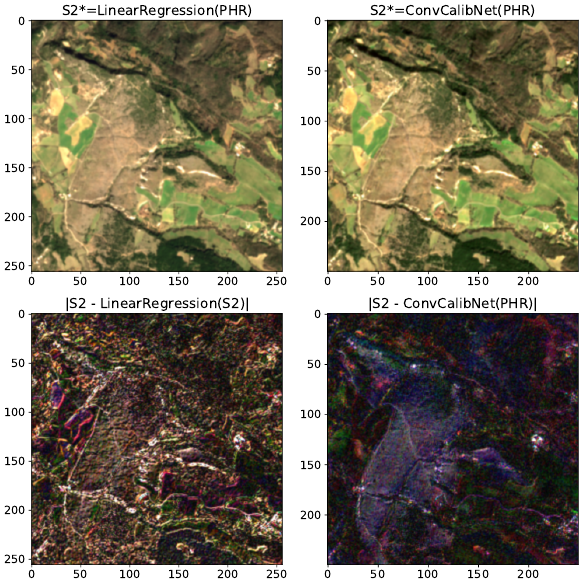
Figure 7. Prediction and prediction error for Linear Regression and ConvCalibNet at 10m resolution.